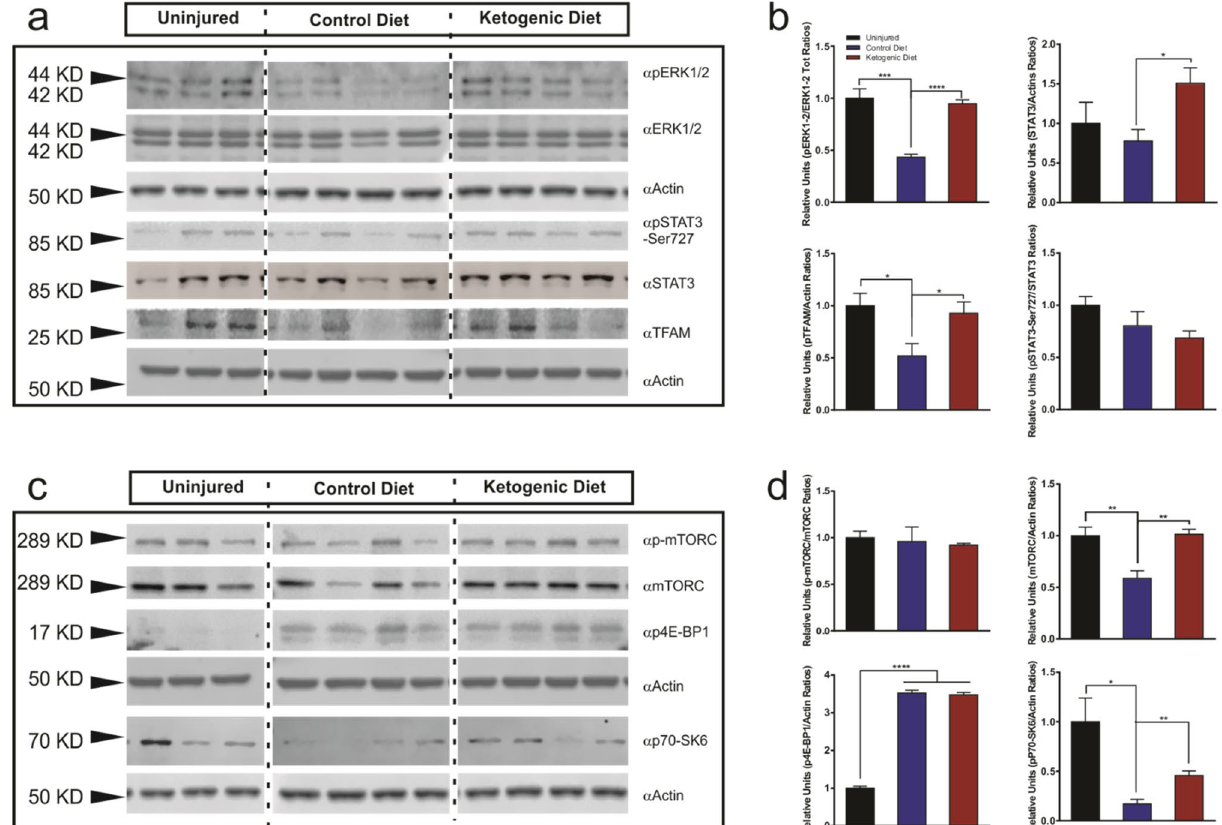
Figure 4. Western blot analysis of mTFAM and members of the MAPK, mTOR and STAT signaling pathways after KD treatment in spinal cord tissue homogenates. ( a ) Immunoblots showing an increase in